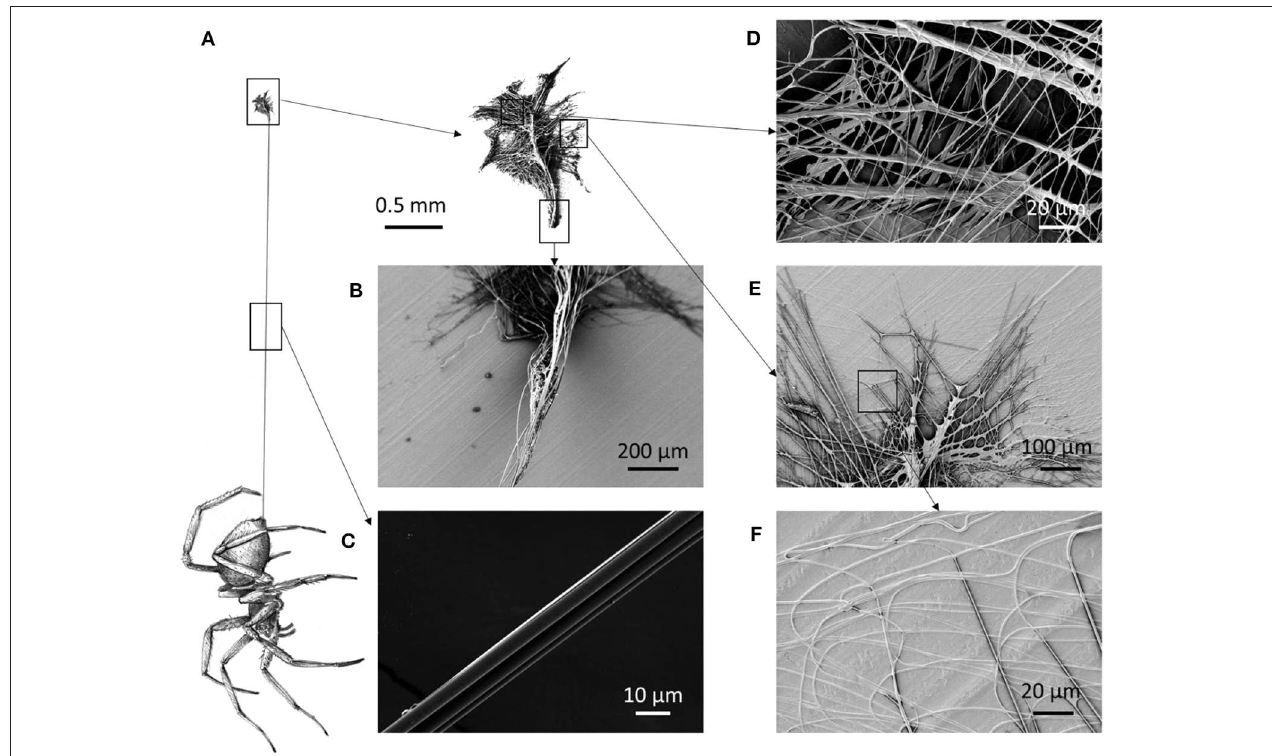
FIGURE 1 | (A) Schematic of a spider that spins its dragline, anchored to the substrate by means of an attachment disc. (B) The initial part of the dragline is composed of more threads than the (C) distal part of the dragline. (D) Scanning electron microscopy (SEM) picture of the median part of the attachment disc, (E) the lateral part, and (F) an enlargement of the lateral part, which shows fibrils attached to the